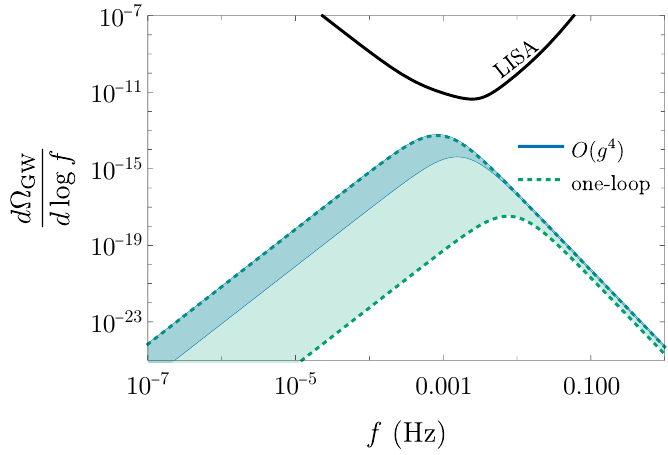
Figure 1. The gravitational wave spectrum from a first-order phase transition in the Z 2 -symmetric xSM, together with the LISA Science Requirements sensitivity curve [66] in black. The coloured lines and associated theoretical uncertainty bands show the predicted gravitational wave spectrum for a single benchmark parameter point in this model (labelled BM1 in section 5). The uncertainty bands reflect the variation as a result of varying the renormalisation scale over a factor of 4 for these two different approximations. For more details see section 6. The LISA signal-to-noise ratio, assuming a 3 year mission profile and using PTPlot [3] for the computation, varies from 0.017 to 0.19 in the O ( g 4 ) approximation, and from 2 . 3 × 10 − 6 to 0.17 in the one-loop